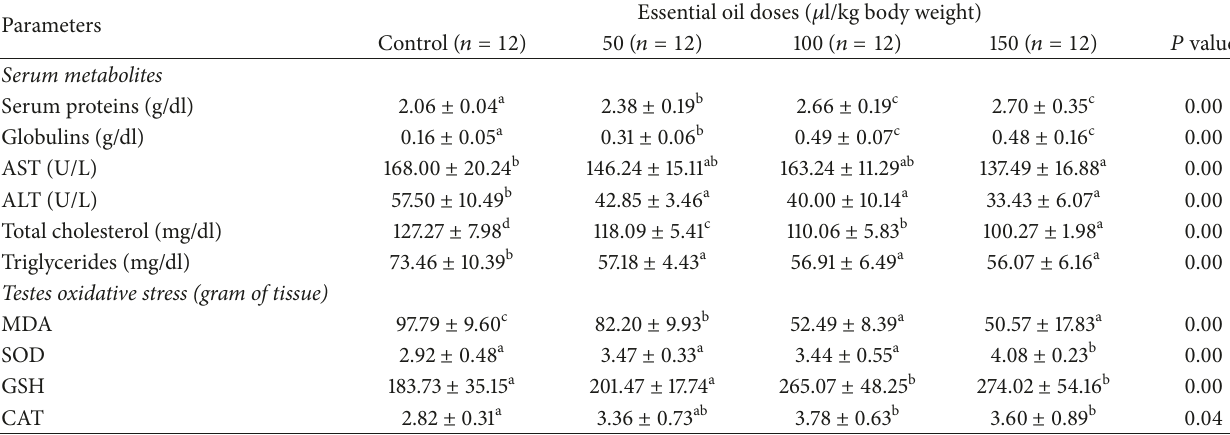
Table 4: Effects of graded levels of ginger essential oil on serum biochemical and testes oxidative stress characteristics